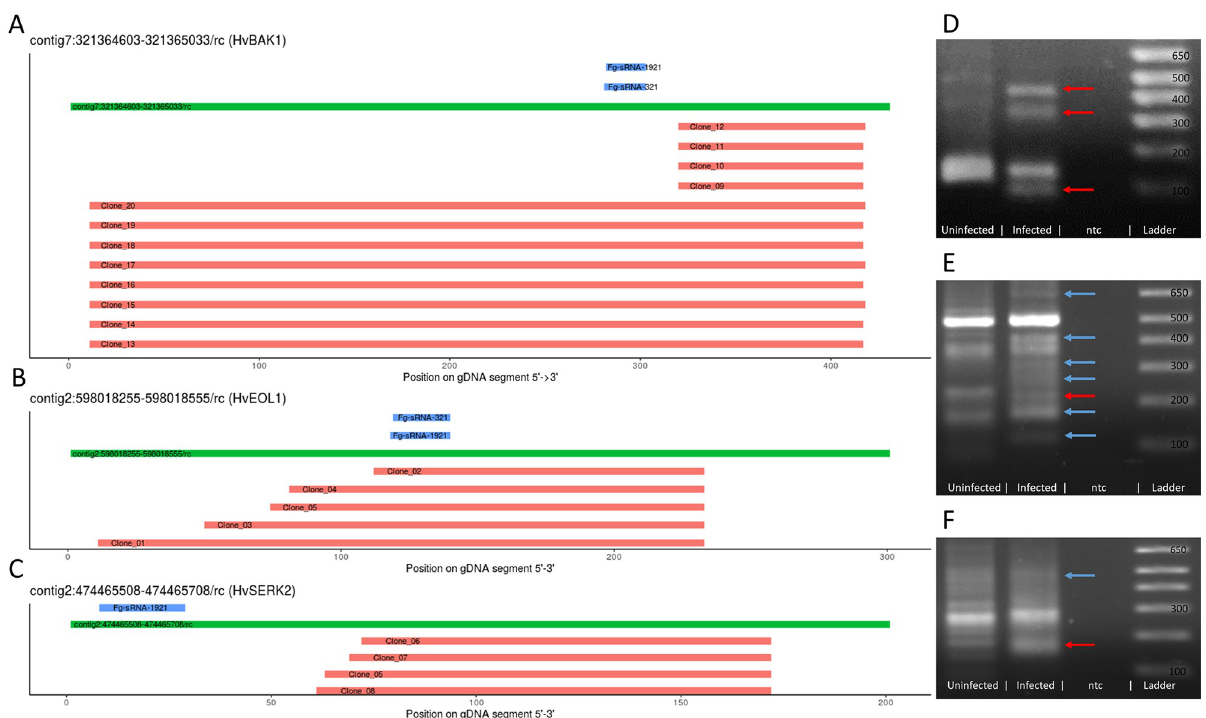
Fig 6. Analysis of potential target sites of Fg -sRNAs as determined by RLM-RACE products. A,B,C Potential target sites of Fg -sRNA-321 and Fg - sRNA-1921 predicted by TAPIR (blue), genomic DNA (GPv1, GCA_902500625.1, A: contig7:321364603–321365033, B: contig2:598018255–598018555, C: contig2:474465508–474465708) of barley cv. Golden Promise (green), and the alignment of sequences derived from the RLM-RACE PCR (red) relative to the Hv -gDNA and Fg -sRNAs. D,E,F PCR-products of the second nested RLM-RACE-PCR visualized in an EtBr-Agarose gel. Red arrows indicate excised bands and blue arrows indicate infection specific